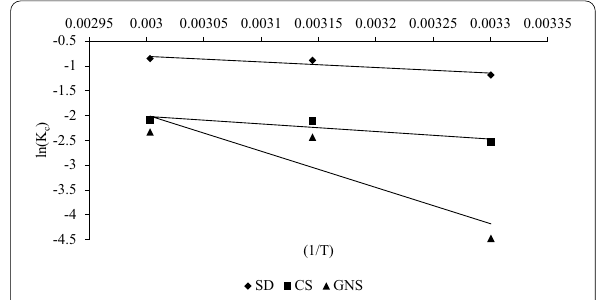
Fig. 10 Van’t hoff plots for MB sorption onto SD, CS and GNS